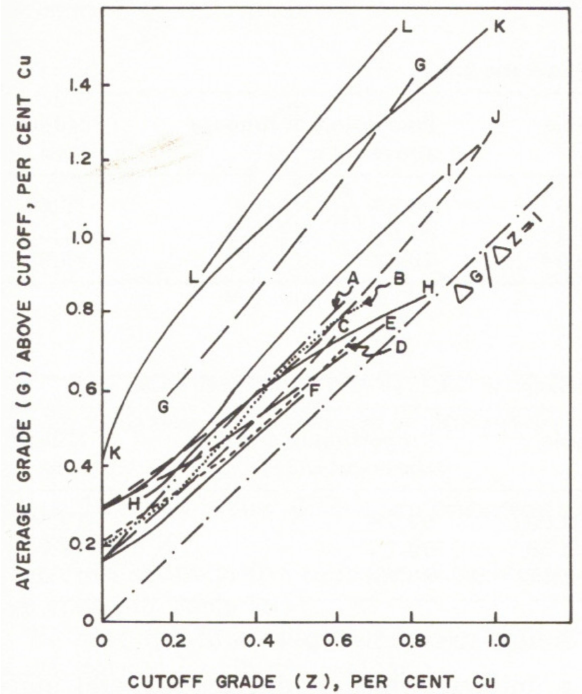
Figure 6. Average grade versus cutoff grade (bench height composited assays) for 12 North American copper prospects [35]. A–L are the 12 cases in the paper of Taylor [35].